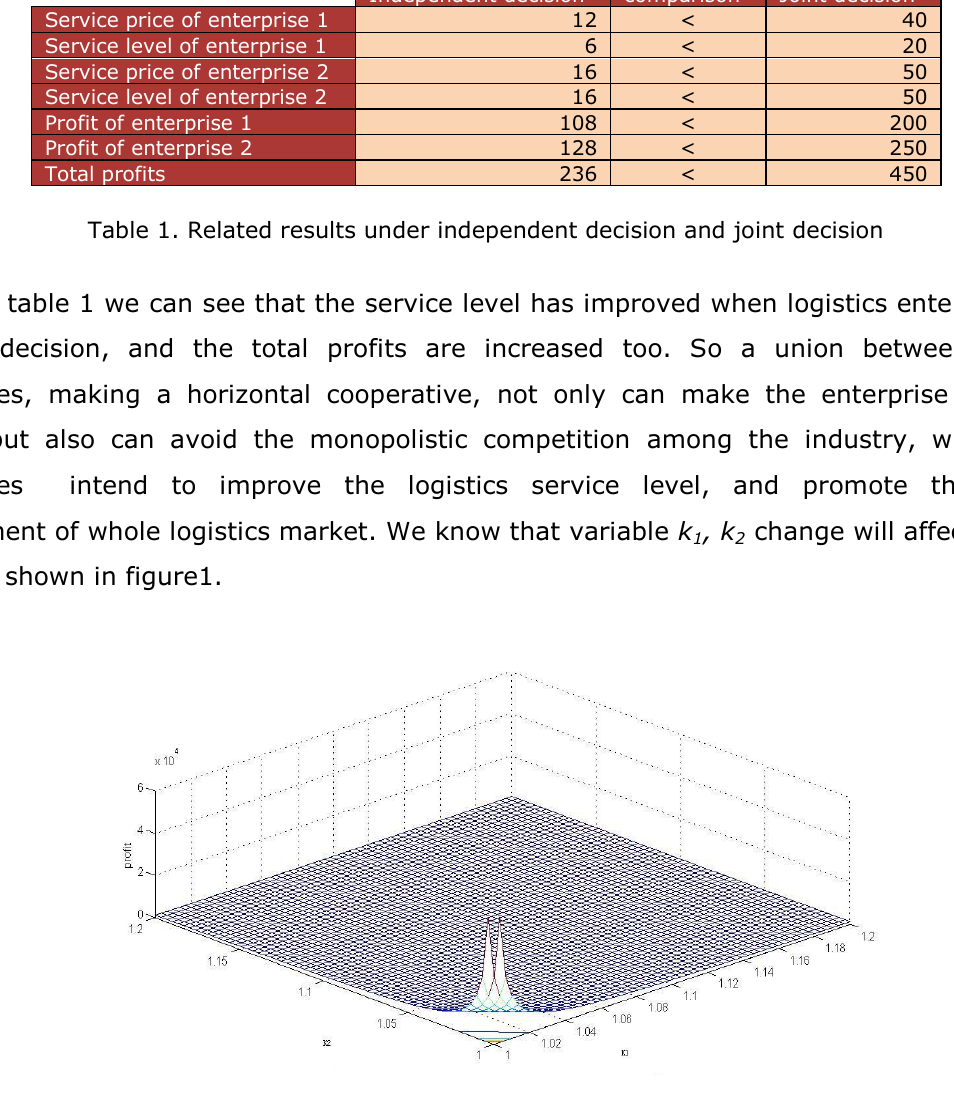
Figure 1. The relationship between the variables k 1 , k 2 and the total